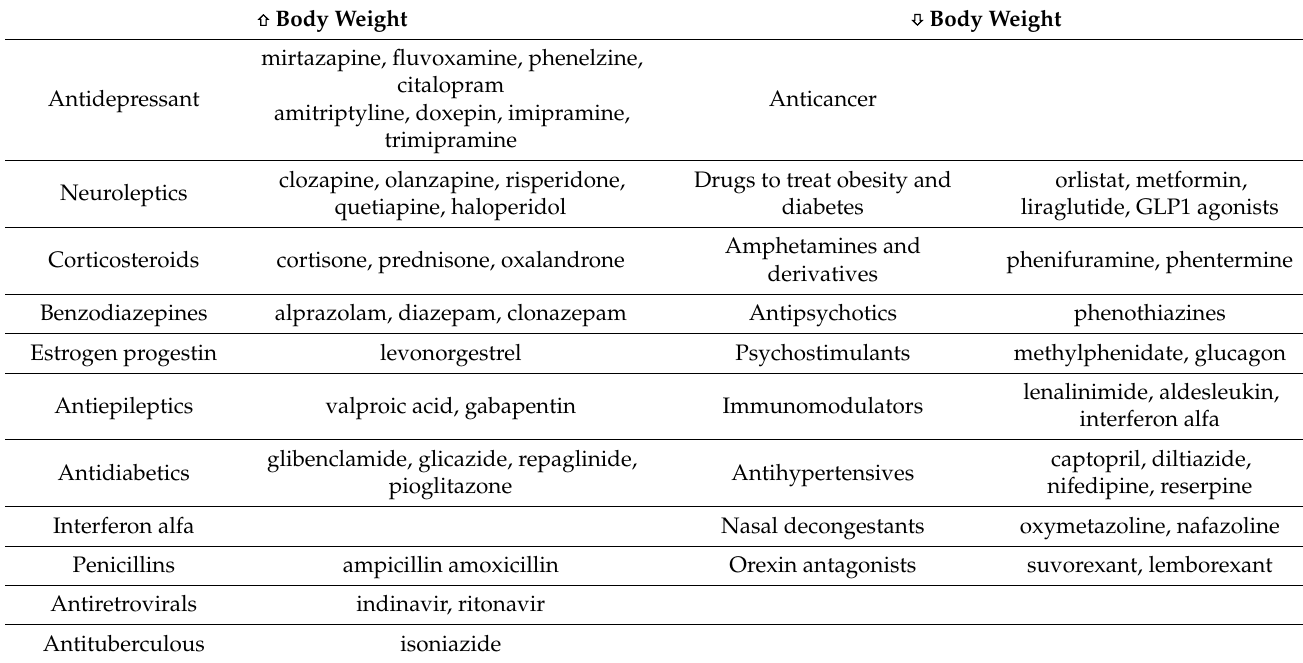
Table 2. Drug and nutritional status interaction. Mechanisms underlying nutritional status changes are discussed in the text.